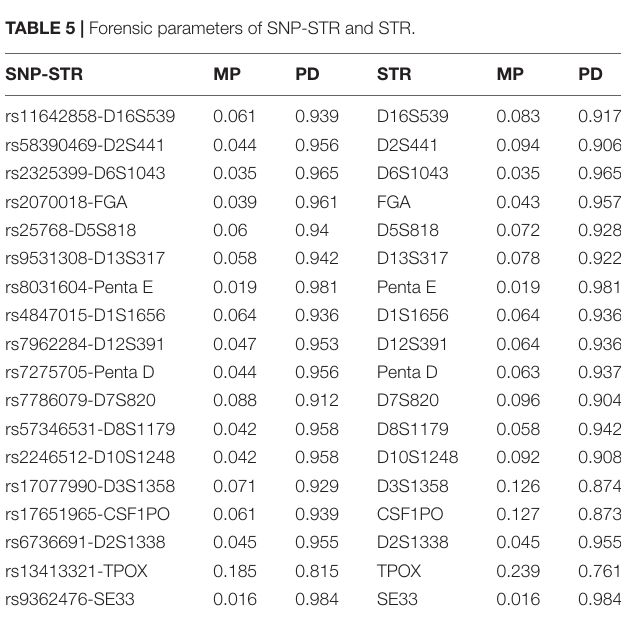
TABLE 5 | Forensic parameters of SNP-STR and